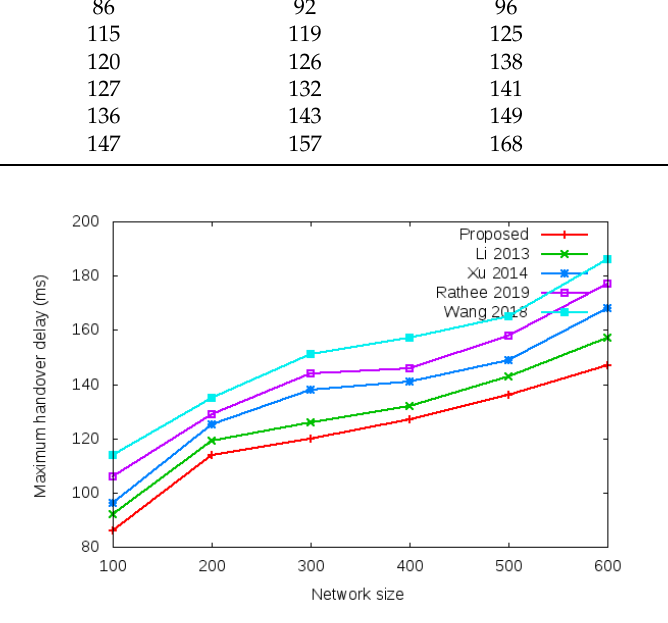
Figure 16. Maximum handover authentication